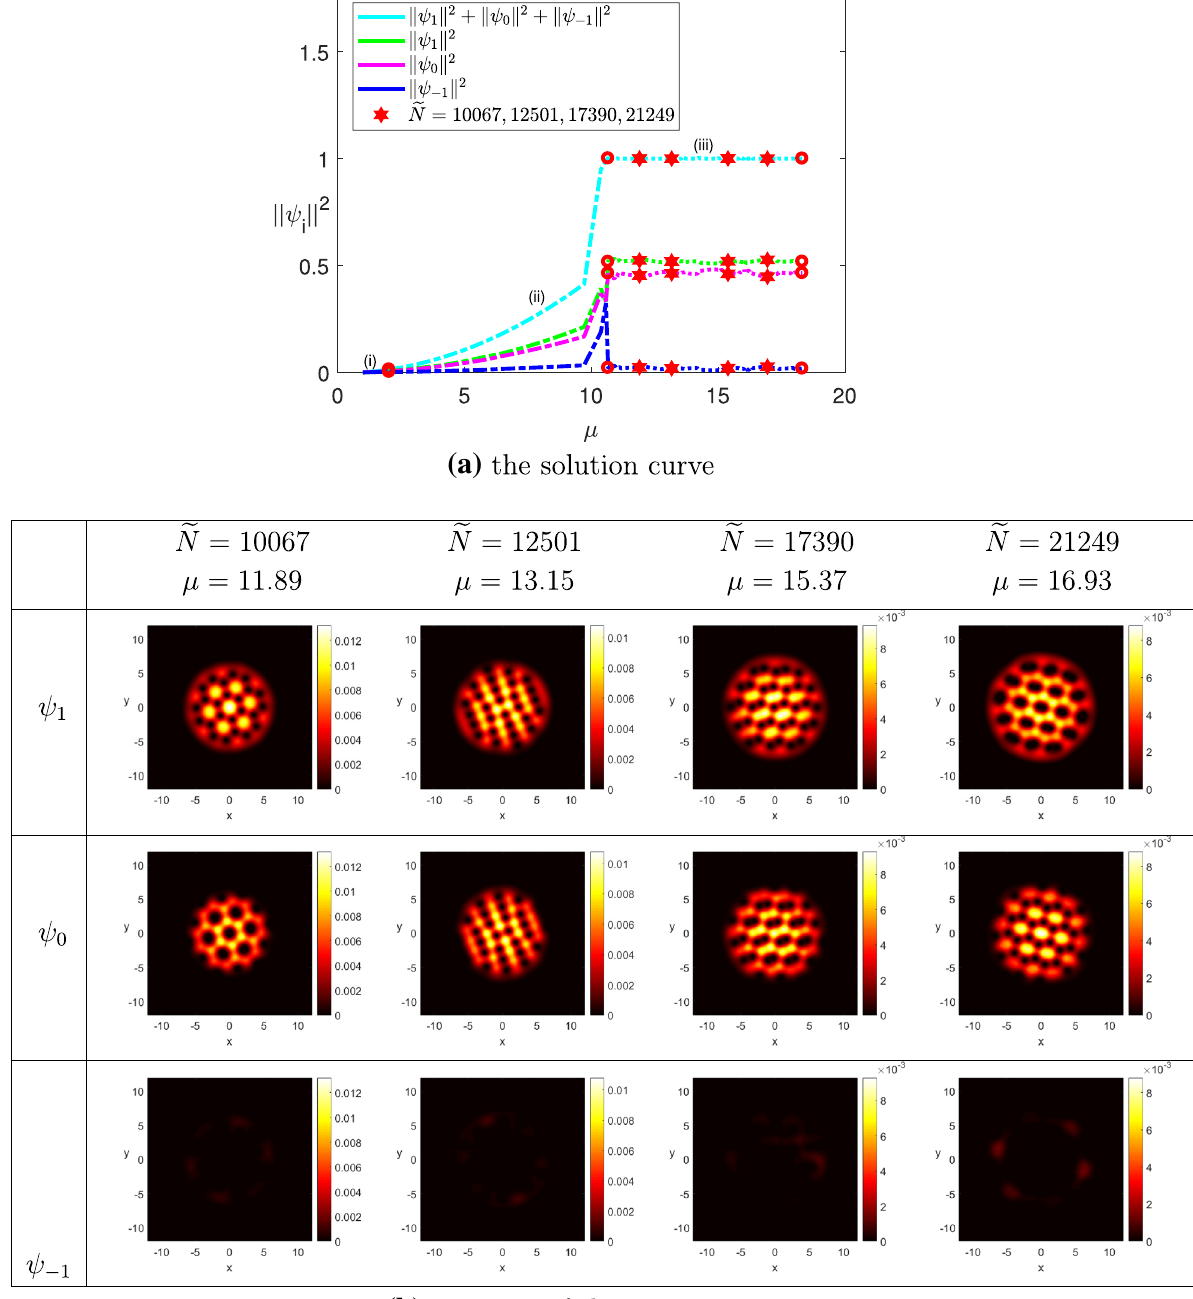
87 Rb , where k 0